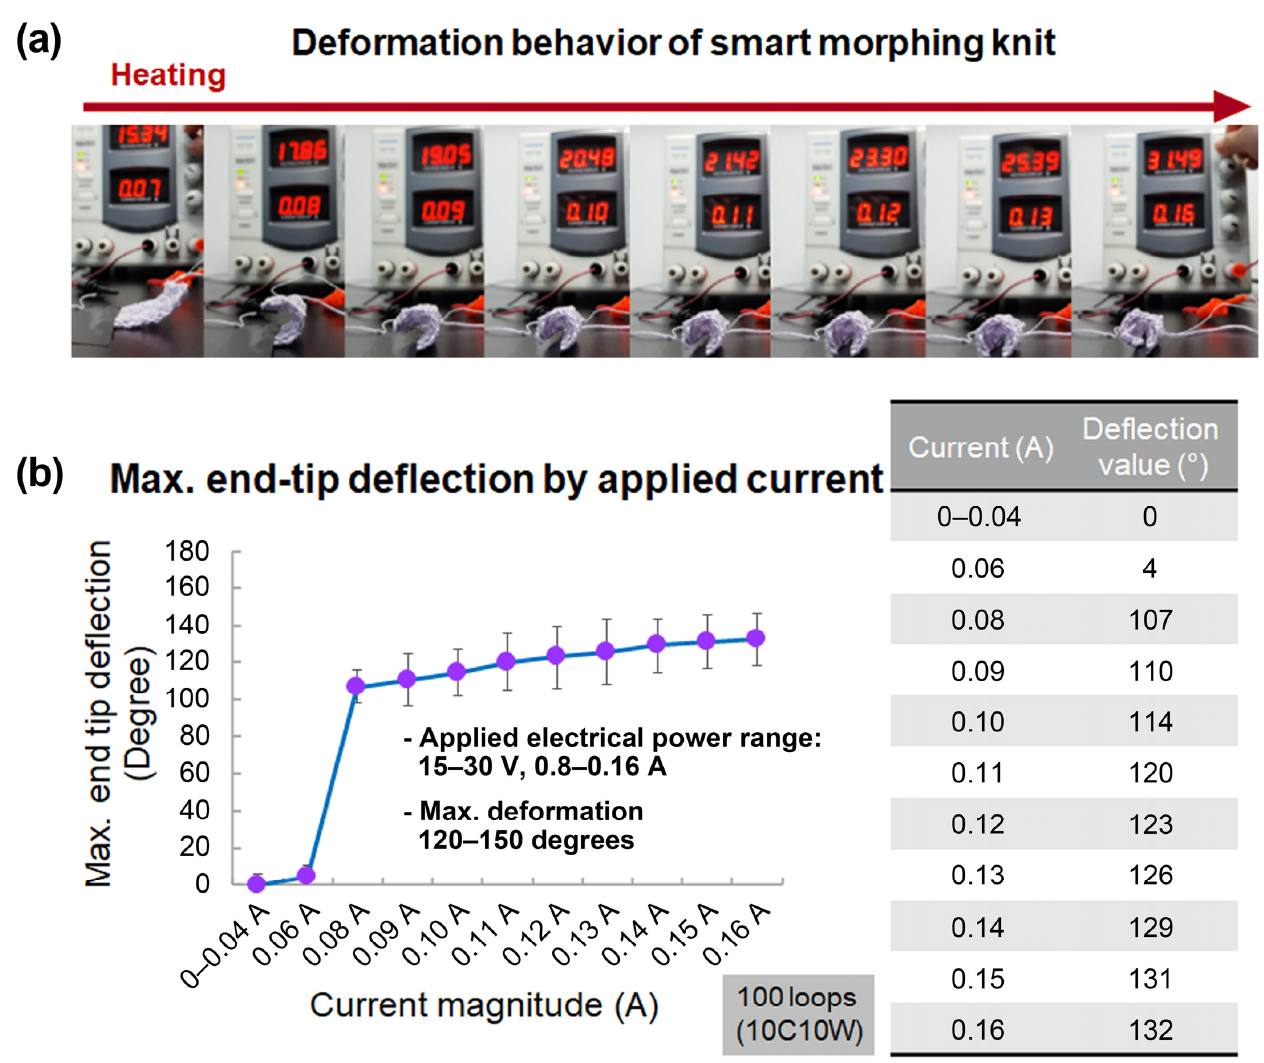
Figure 7. ( a ) The maximum deformation of a textile actuator according to the extent of current flow. ( b ) The maximum bending deformation angle of a 10-course and 10-wale actuator.